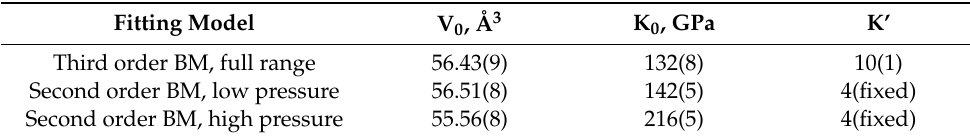
Figure 4. Compressibility data for δ -AlOOH in this study (black) compared with the trend of literature data [10] (green), [21] (blue), and [9] (red). Error bars are smaller than the marker sizes. Table 3. Refined parameters for the δ -AlOOH equation of